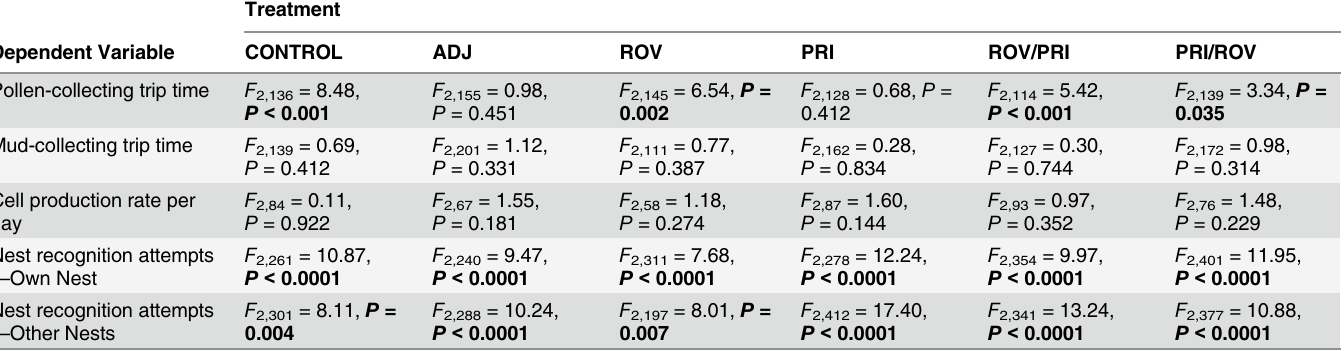
Table 3. ANOVA results for the treatment effects on the pollen-collecting trip times, mud-collecting trip times, cell production rates per day, and the number of nest recognition attempts made to enter her own and other nests by Osmia lignaria females in cages in Lost Hills, California in